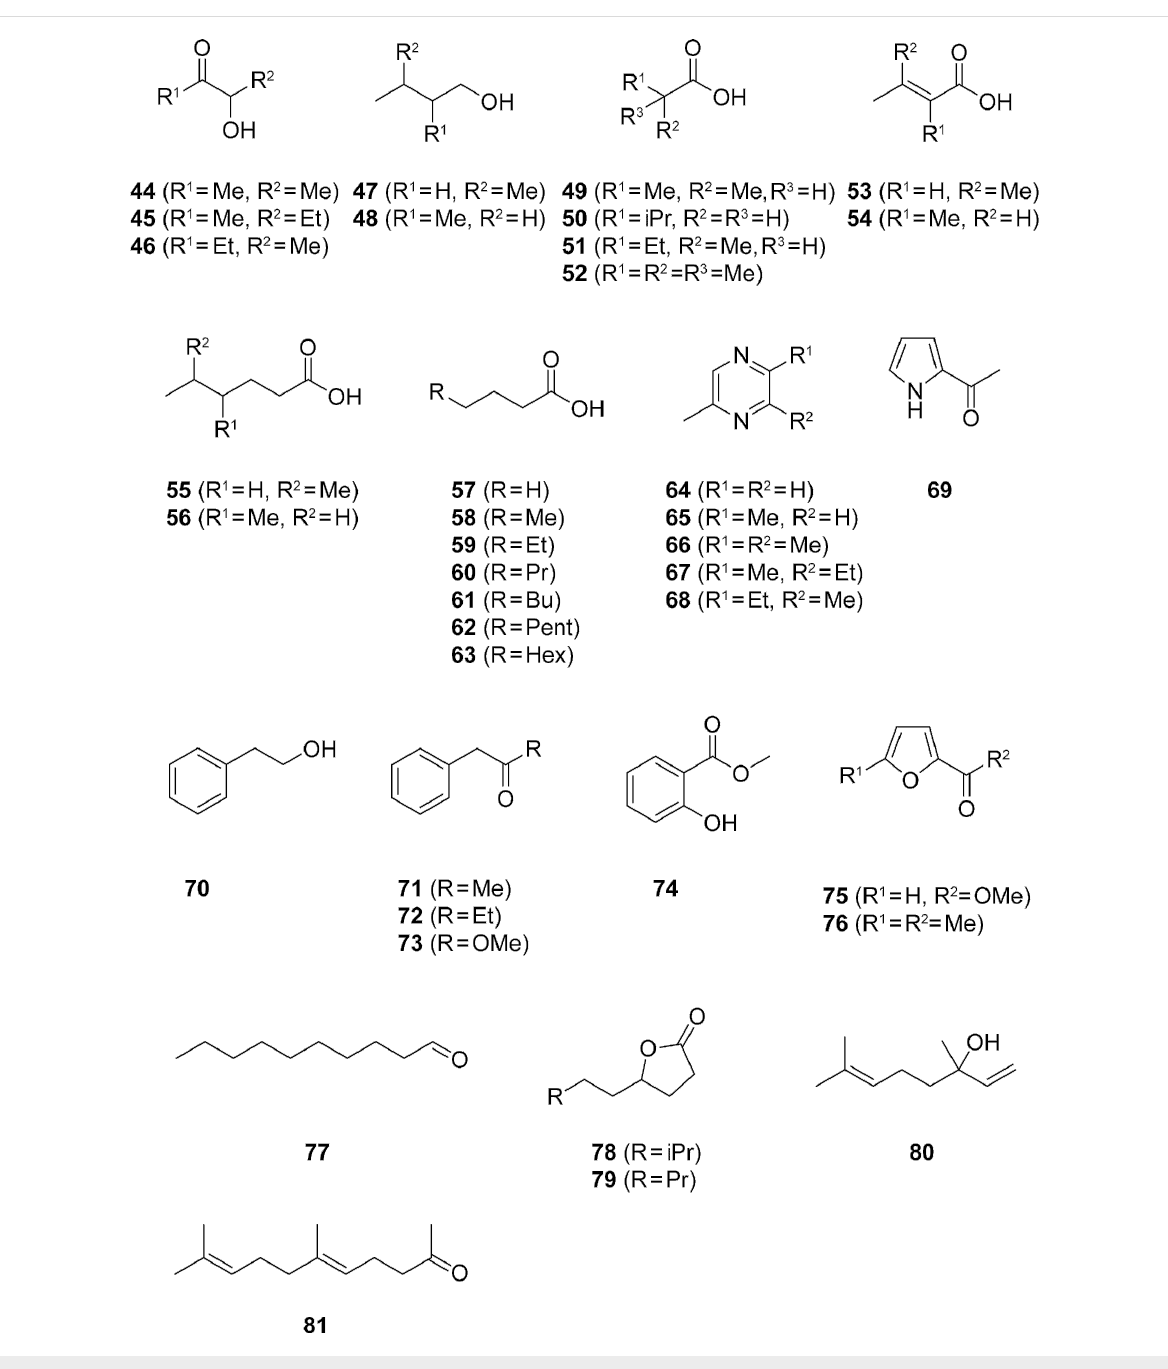
tert -leucine. The acids 53 and 54 can arise from their saturated counterparts 50 and 51 by dehydrogenation. A two-carbon elon- gation of 50 and 51 by means of the fatty acid biosynthetic pathway can generate 55 and 56 , while their reduction to the respective alcohols provides 47 and 48 . Acetoin ( 44 ) was also found as a major compound, together with its derivatives 3-hydroxypentan-2-one ( 45 ) and 2-hydroxypentan-3-one ( 46 ).